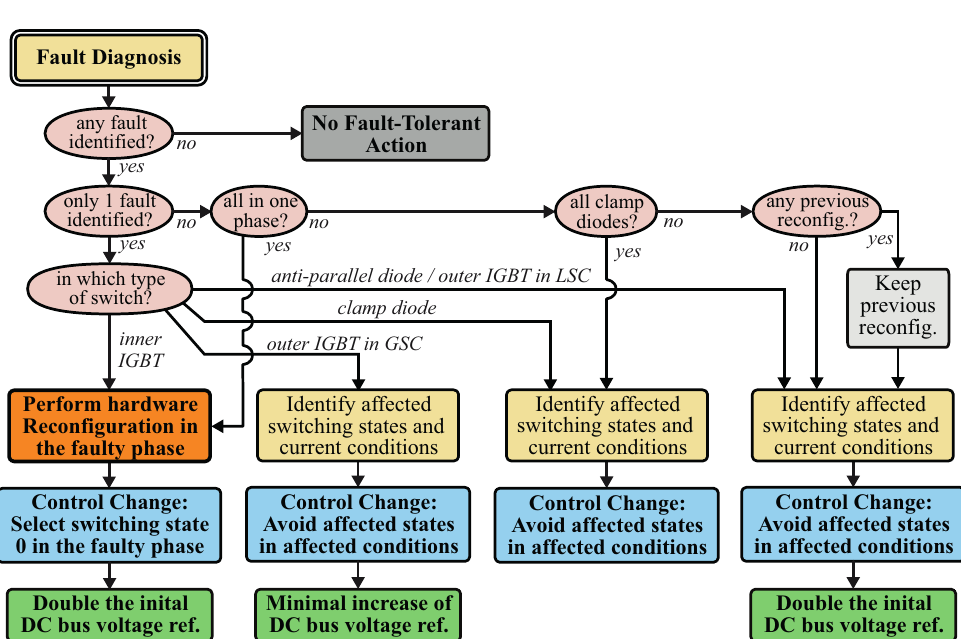
Figure 6. Flowchart of the decision process for fault-tolerant action in the 3-level NPC converters, with minimal hardware